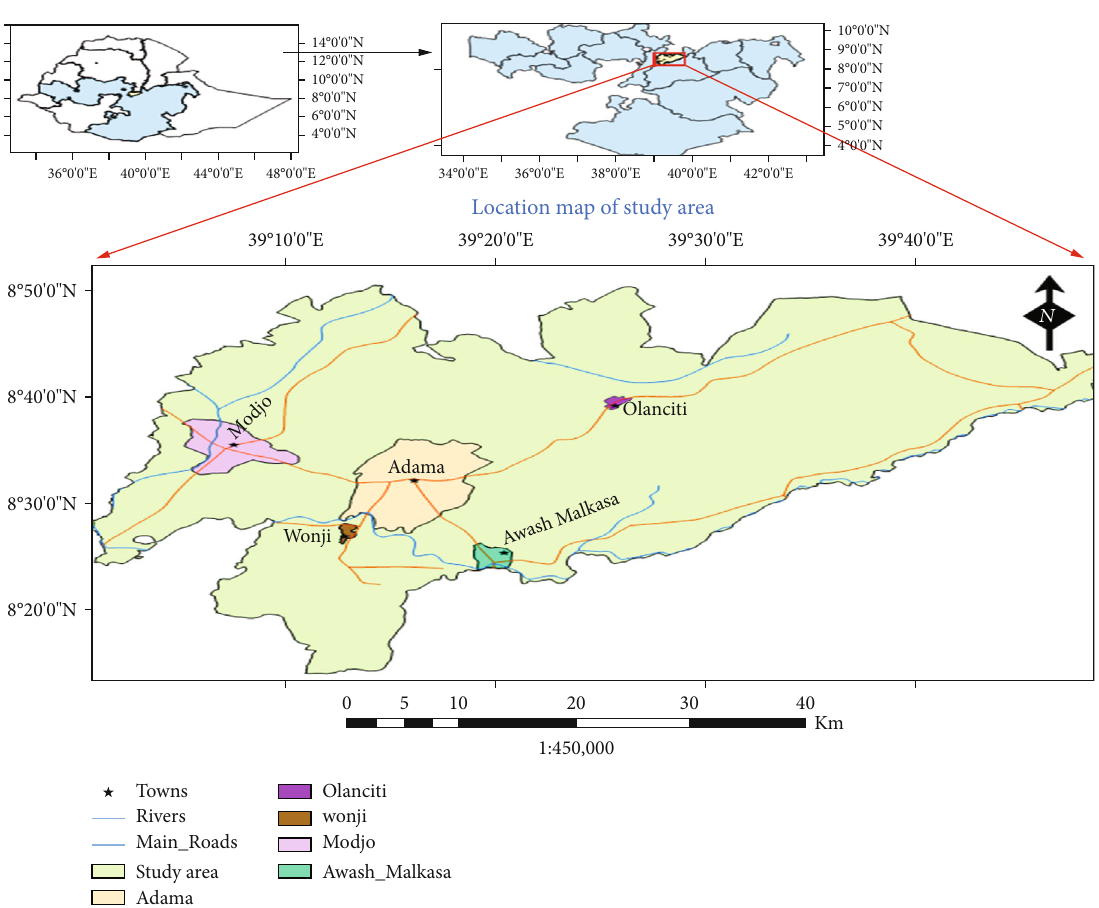
Figure 1: Map of the study area ( fi gure developed by using Arc-GIS Desktop version 10.4).